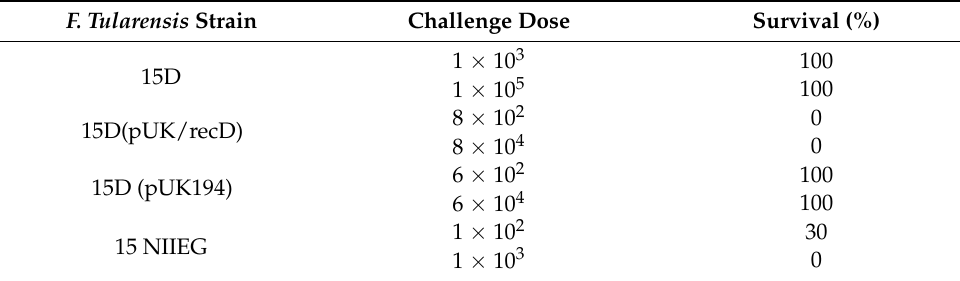
Table 5. BALB/c mice survival after s.c. F. tularensis